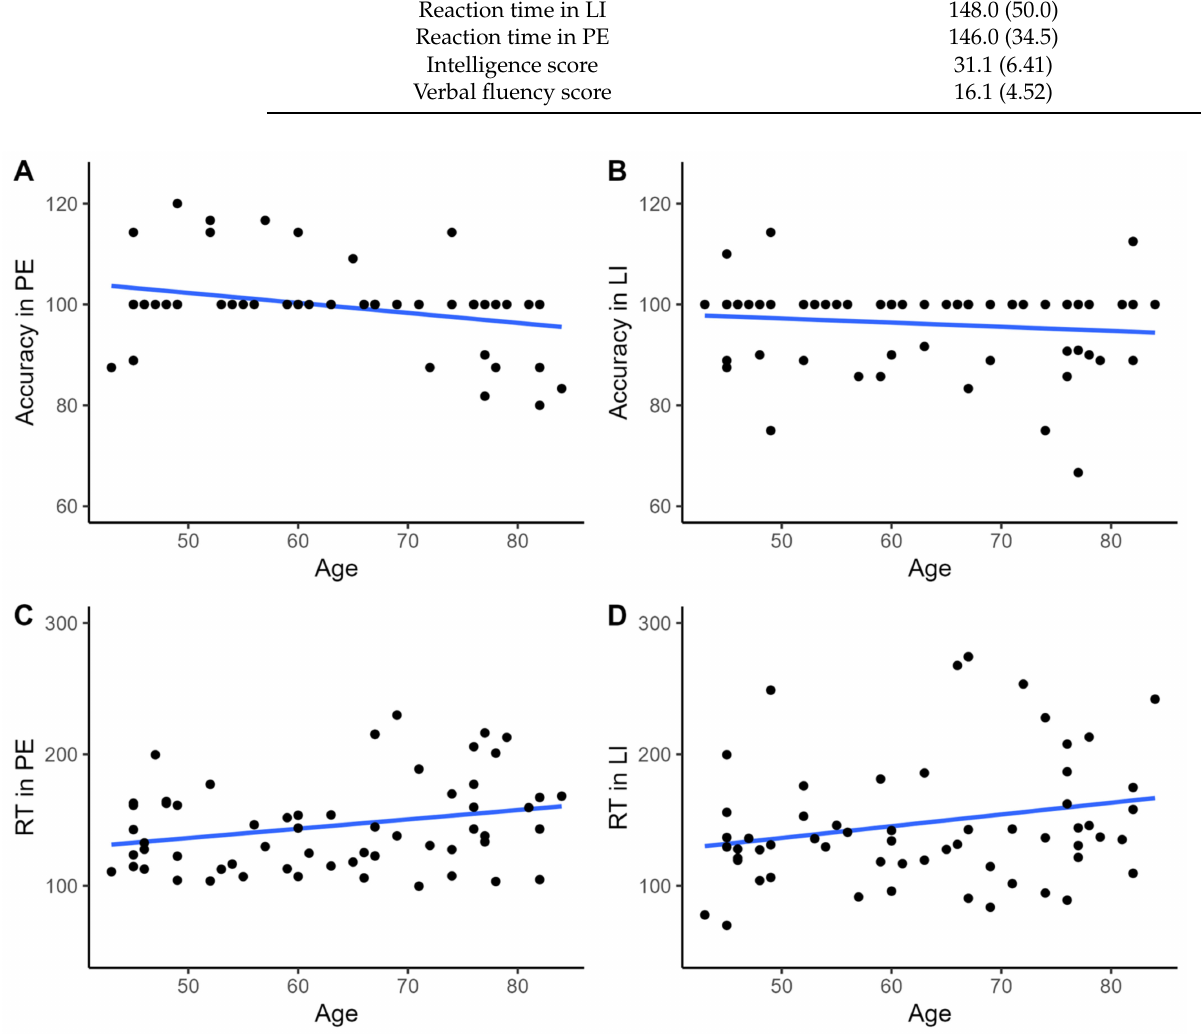
Figure 2. A scatter plot with the line of best fit is used to illustrate the relationship between age and accuracy rates ( A , B ) or reaction times ( C , D ) in apparently healthy